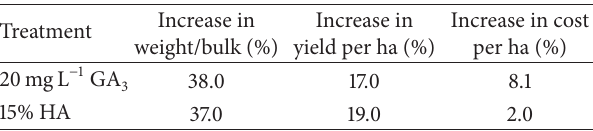
Table 7: Comparison between percentage (%) in weight per bulk, yield, and cost of two treatments.